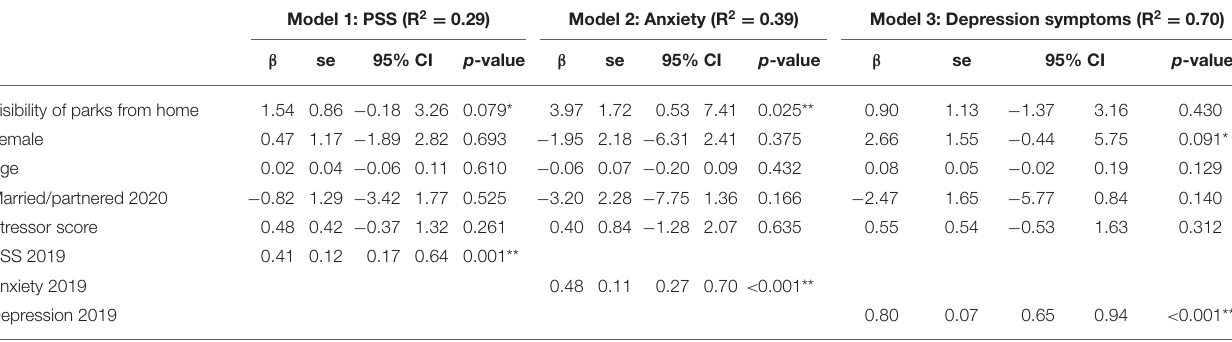
TABLE 4 | Regression model results, predicting Perceived Stress Scores (PSS), anxiety and depression symptoms in 2020. Model 1: PSS (R 2 =